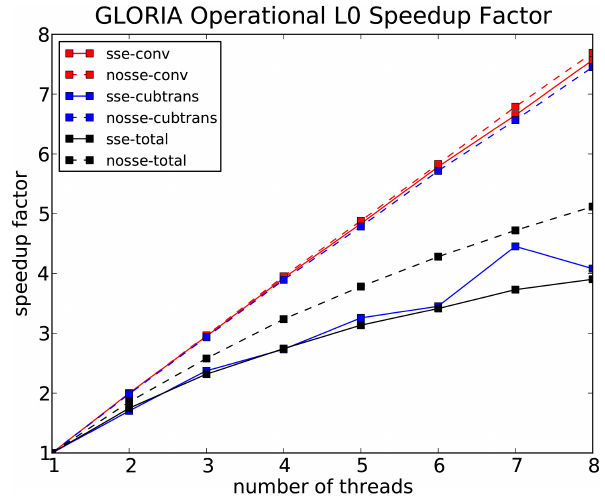
Figure 13. Total runtimes and runtimes for the two most critical cal- culations with increasing level of OpenMP parallelisation, with and without the use of SSE vectorisation. Red: runtime for the convolu- tion process, blue: runtime for the cuboid transposition, black: total runtime. Solid lines show the runtime with vectorisation, dashed lines without vectorisation.